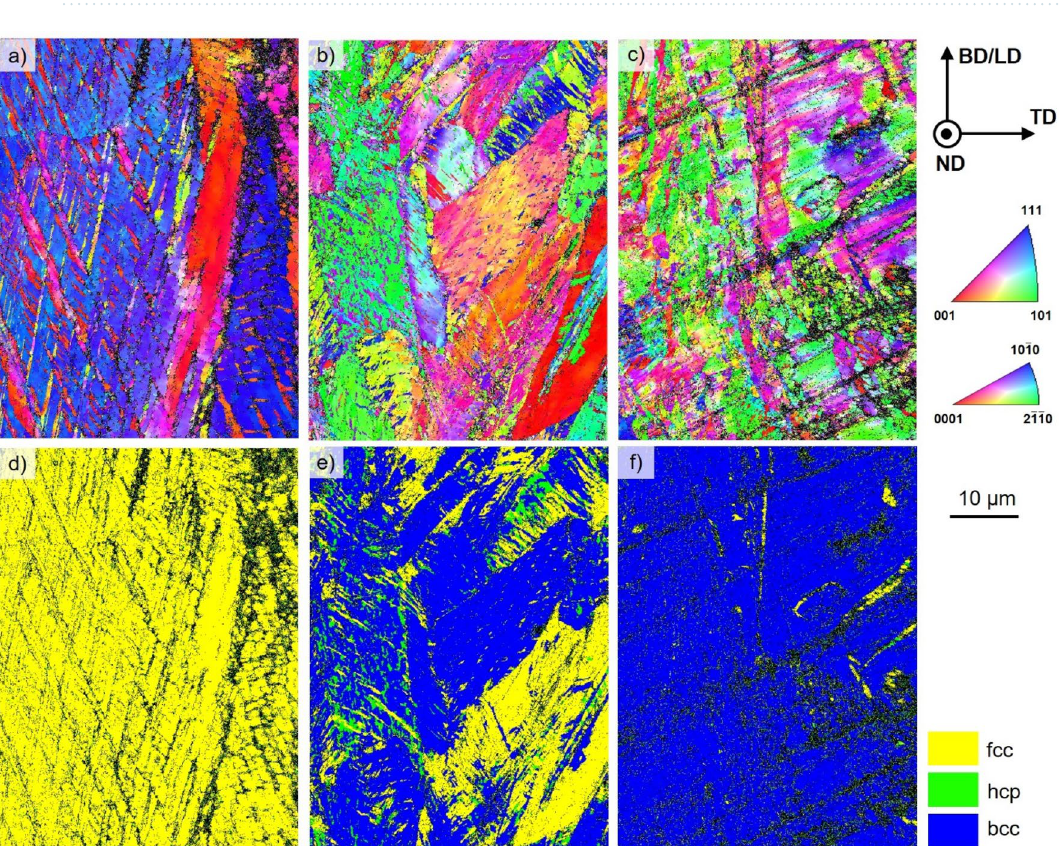
Figure 4. EBSD orientation maps of PBF-LB/M-16-6-9 ( a ), PBF-LB/M-16-6-6 ( b ), PBF-LB/M-16-6-3 ( c ) after tensile testing plotted with respect to BD || LD; the corresponding phase maps after deformation are shown in ( d – f ). Non-indexed areas revealed by black color are due to high local deformation. The step size for all maps was 0.075